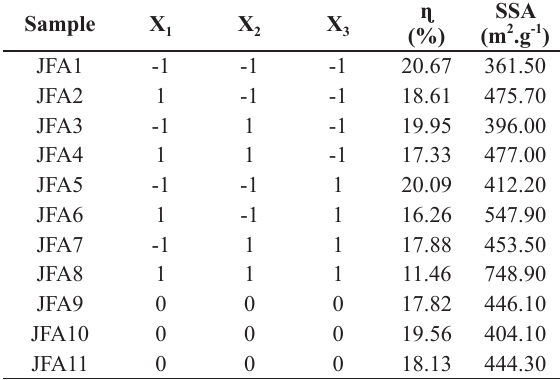
Experimental planning matrix with answers for yield (η) and specific surface area